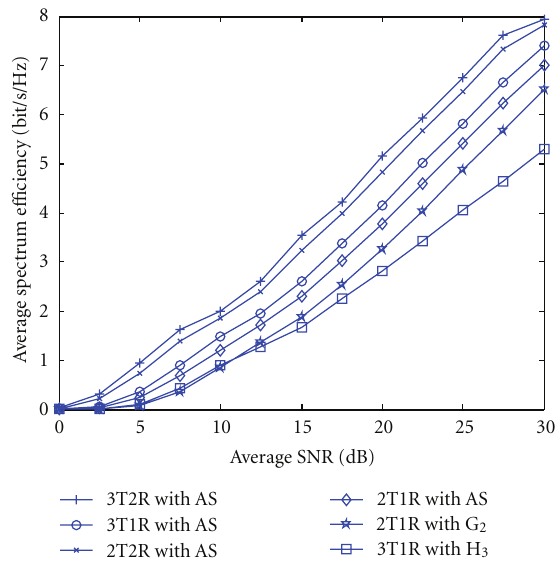
Figure 1: Average SE of CLD-AS with di ff erent transmit antennas and one receive